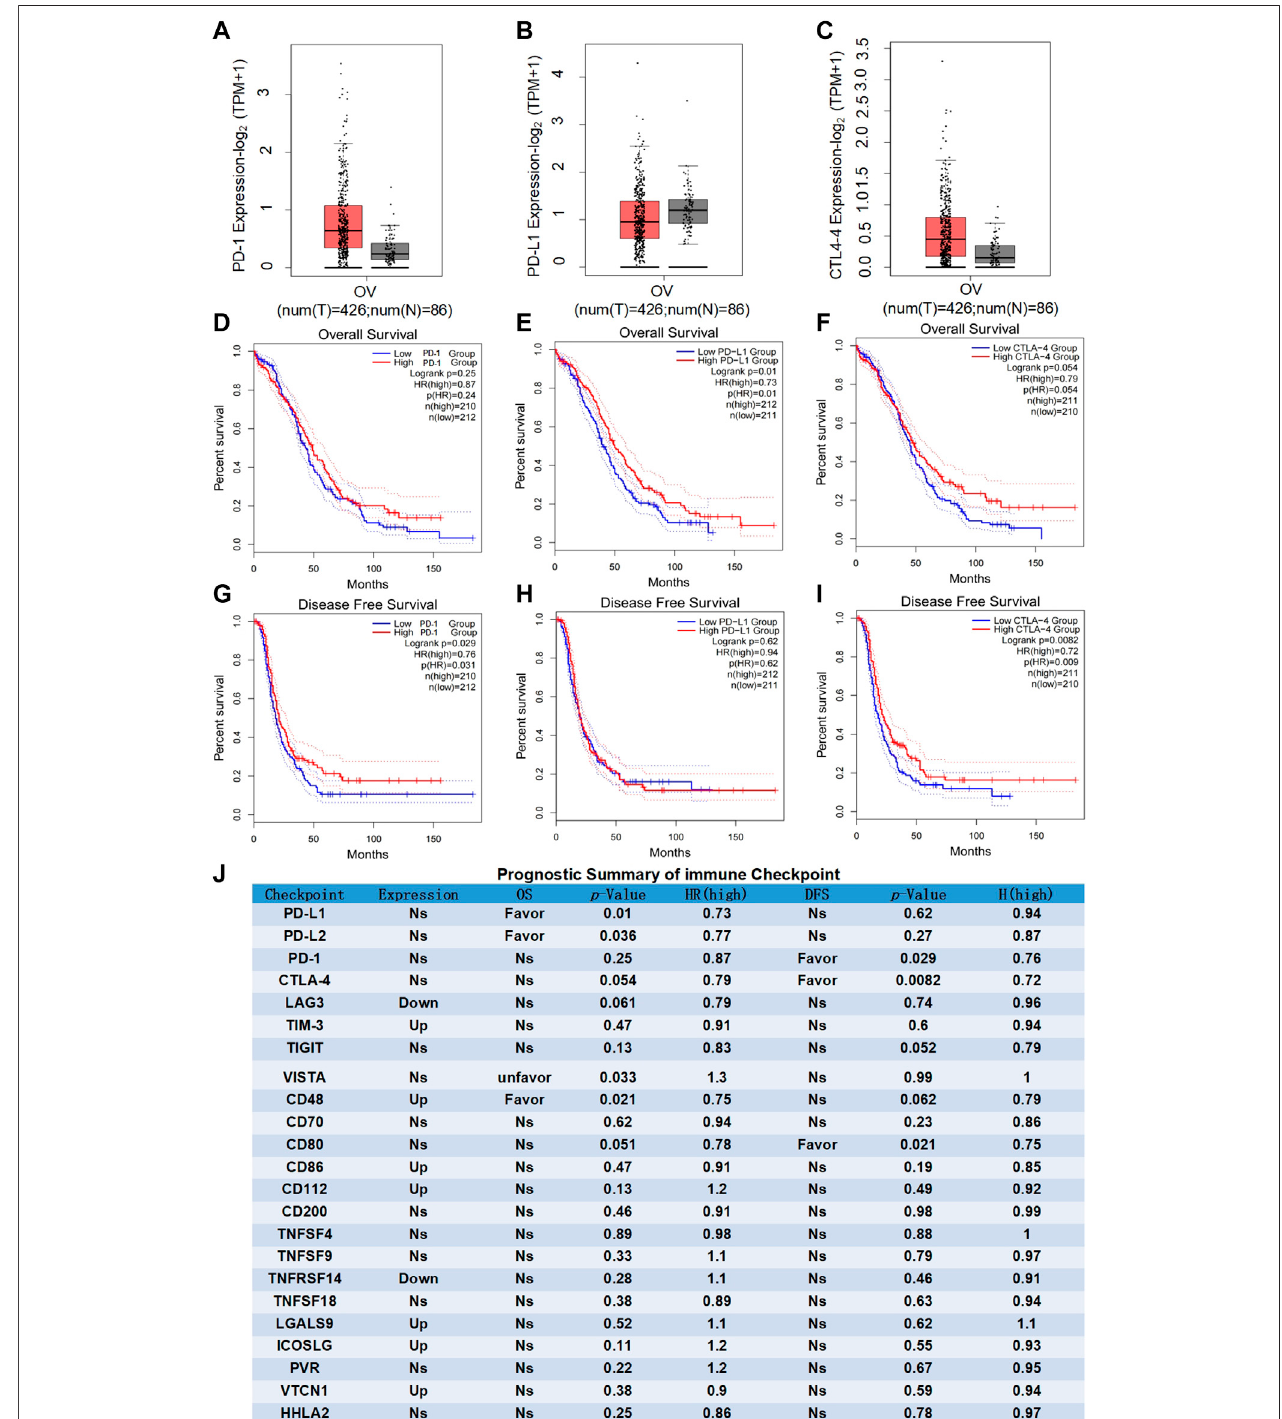
FIGURE 1 | Prognostic analysis of immune checkpoints in ovarian cancer. (A – C) Differential expression analysis of common immune checkpoints in ovarian cancer.Boxplotswithjitter(size=0.5)forcomparingPD-1 (A) ,PD-LI (B) andCTLA-4 (C) expressioninovariancancerandnormalovariantissuesweremadebyGEPIA. T, tumor samples; N, normal samples. One-way ANOVA was used for differential analysis. Genes with higher |log2FC| values ( > 1) and lower q-values ( < 0.01) were recognized asdifferentiallyexpressed genes. D-F,OSanalysisofcommon immune checkpointsinovarian cancer.Kaplan-MeierOScurves comparing thegroups with different expression levels of PD-1 (D) PD-L1 (E) and CTLA-4 (F) in ovarian cancer (TCGA tumor) were made by GEPIA. G-I, DFS analysis of common immune checkpoints in ovarian cancer. Kaplan-Meier DFS curves comparingthe groups with different expression levels of PD-1 (G) , PD-L1 (H) and CTLA-4 (I) in ovarian cancer